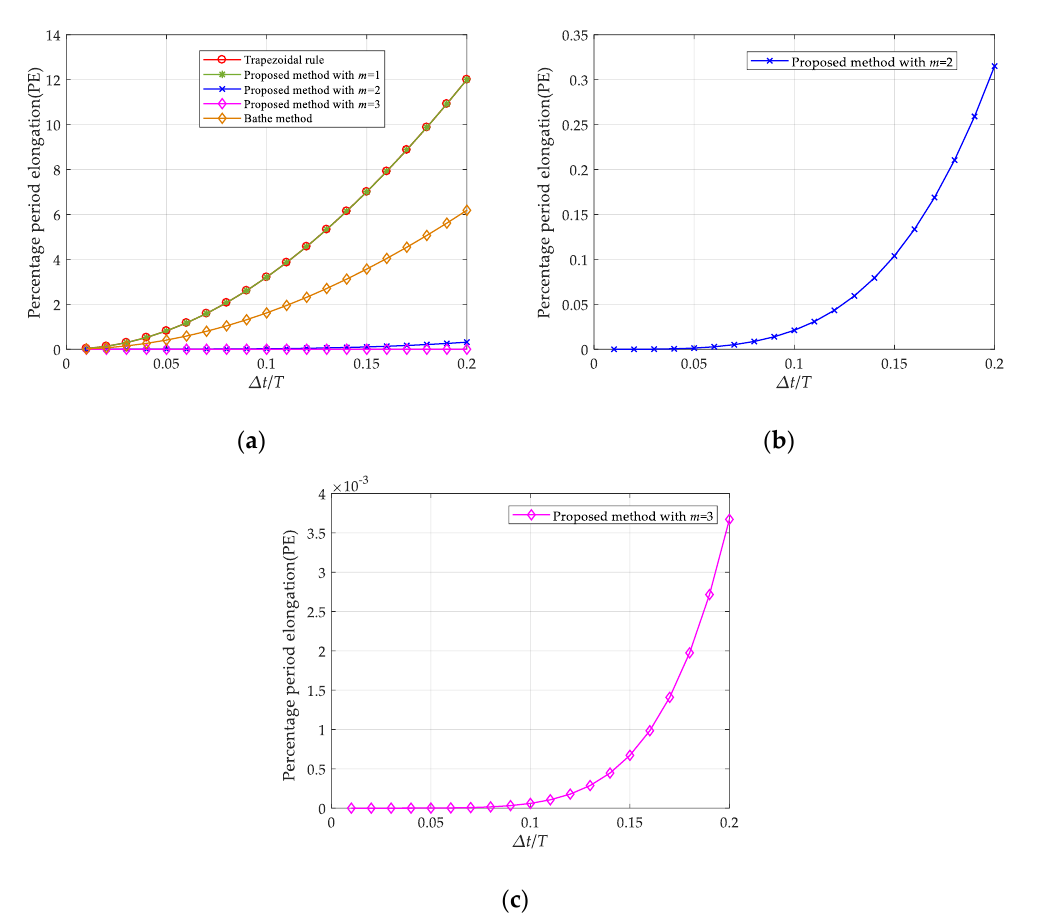
Figure 2. Percentage period elongation due to the proposed algorithm with m = 1,2,3: ( a ) Percentage period elongation with m = 1 – 3 comparing with that of trapezoidal rule and Bathe method. ( b ) Percentage period elongation with m = 2. ( c ) Percentage period elongation with m = 3.